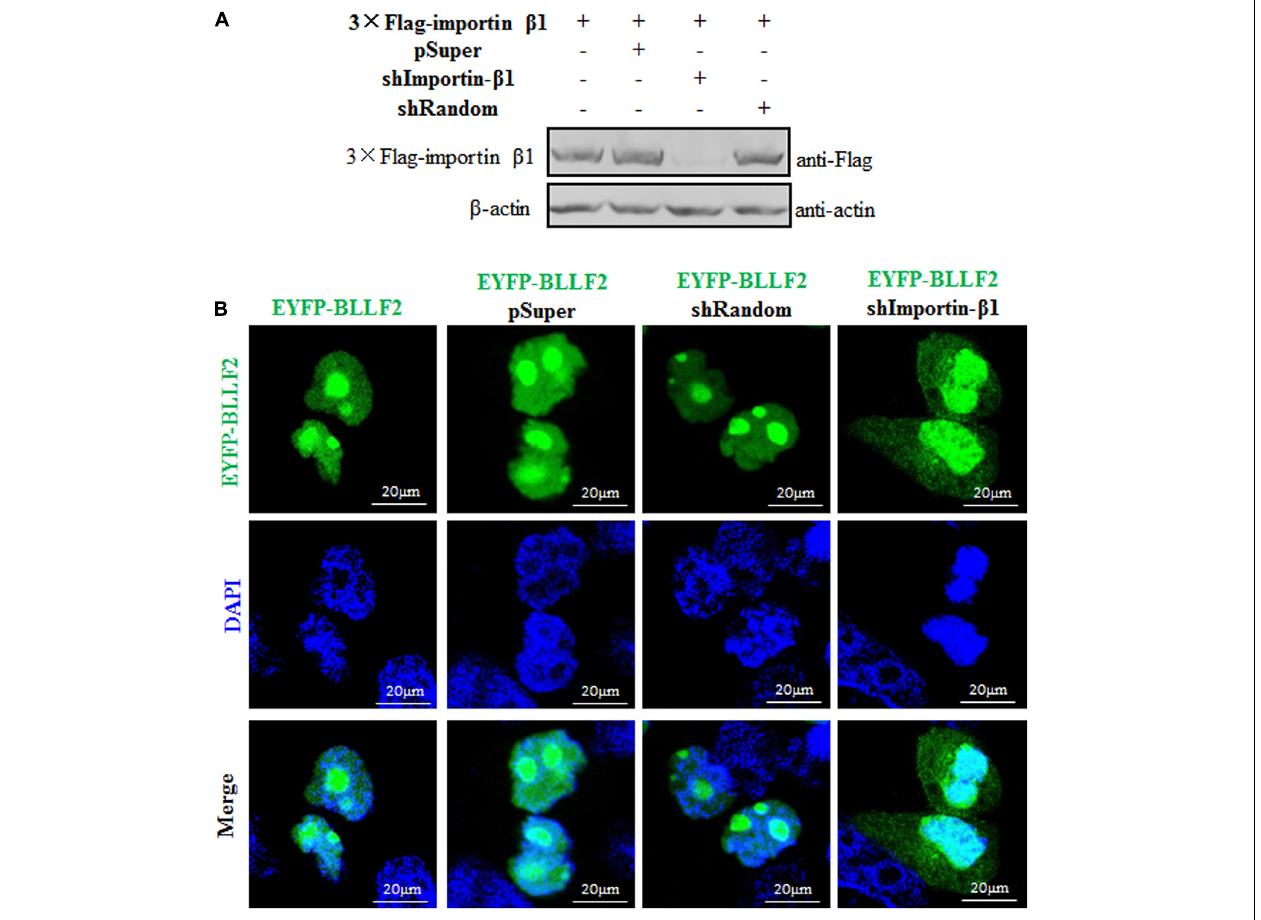
FIGURE 7 | Subcellular localization of BLLF2 when importin β 1 was knocked down. (A) Validation of knockdown efficiency of the constructed shImportin- β 1 expression plasmid. HEK293T cells were transfected with 3 × Flag-importin β 1 expression plasmid or co-transfected with the expression plasmids combination of 3 × Flag-importin β 1/pSuper, 3 × Flag-importin β 1/shRandom, or 3 × Flag-importin β 1/shImportin- β 1 for 24 h. Then, cells were lysed, and WB was carried out with anti-Flag mAb. β -actin was used as a loading control. (B) pEYFP-BLLF2 was transfected into COS-7 cells, or pEYFP-BLLF2 was co-transfected with pSuper, shRandom, or shImportin- β 1 expression plasmid into COS-7 cells. At 24 h post-transfection, confocal fluorescence microscopy was executed to examine the subcellular localization of